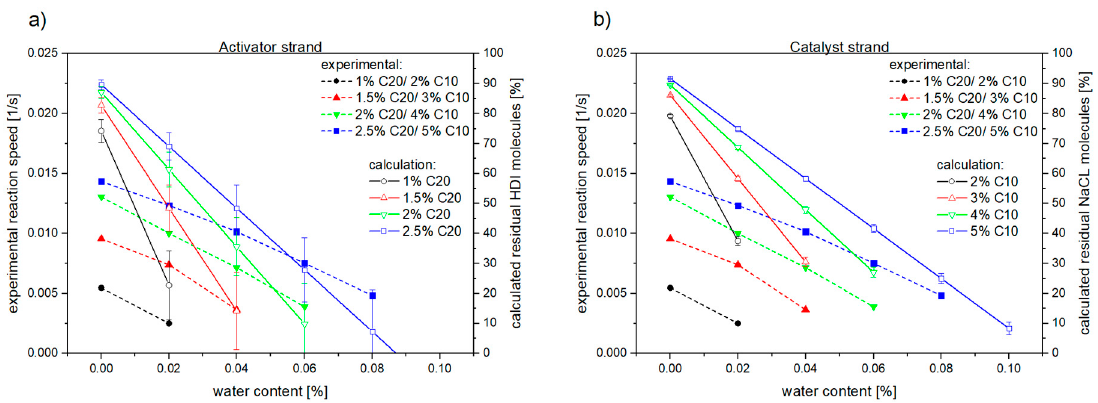
Figure 4. Comparison of calculated remaining reactive molecules to experimental reaction speed of ( a ) different activator concentrations and ( b ) different catalyst concentrations [8].